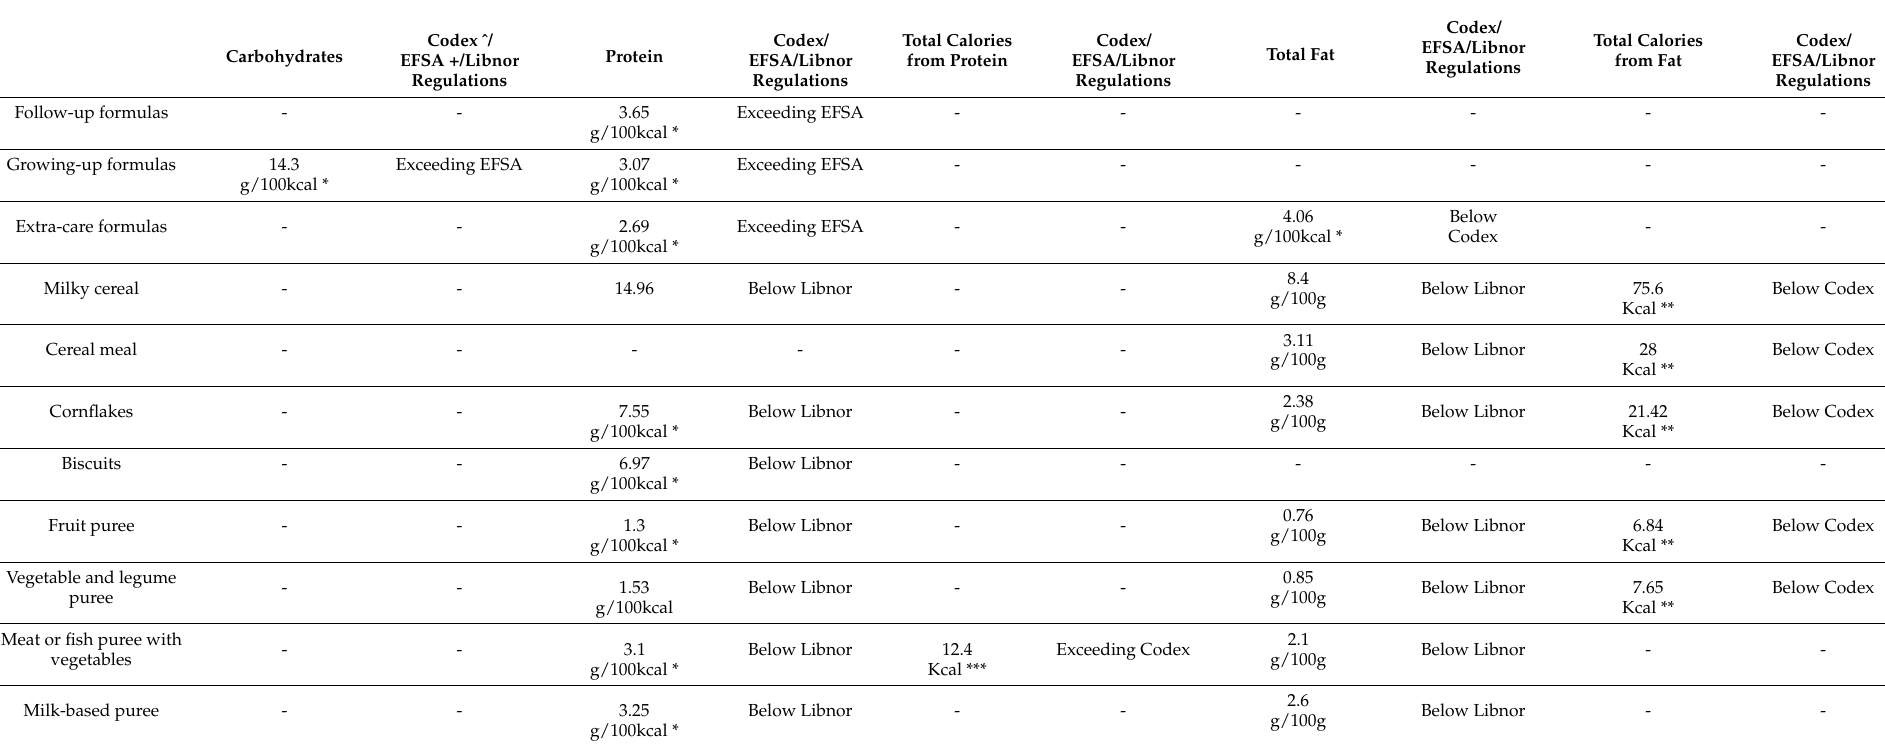
Table 1. Comparison between the measured values of nutrient content in infant formulas with the